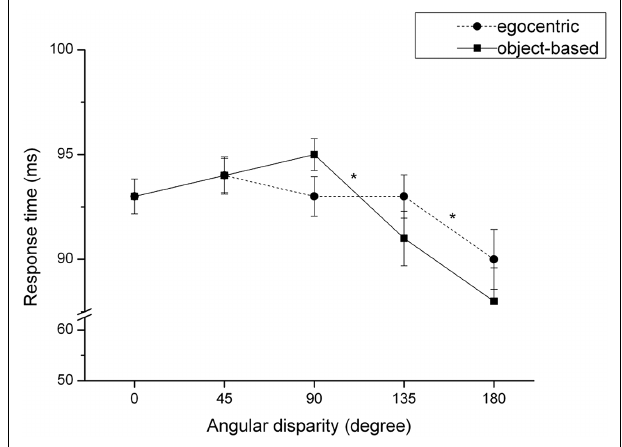
FIGURE 7 |Accuracy rate (mean and SE) dependent on angular disparity for object-based and egocentric transformations. * p < 0.001.